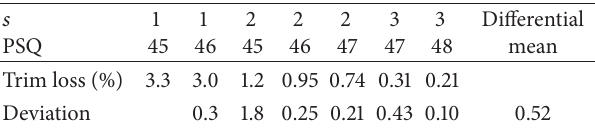
Table 5: The comparison results of TL 𝑓𝑠 (%) for different scenarios.